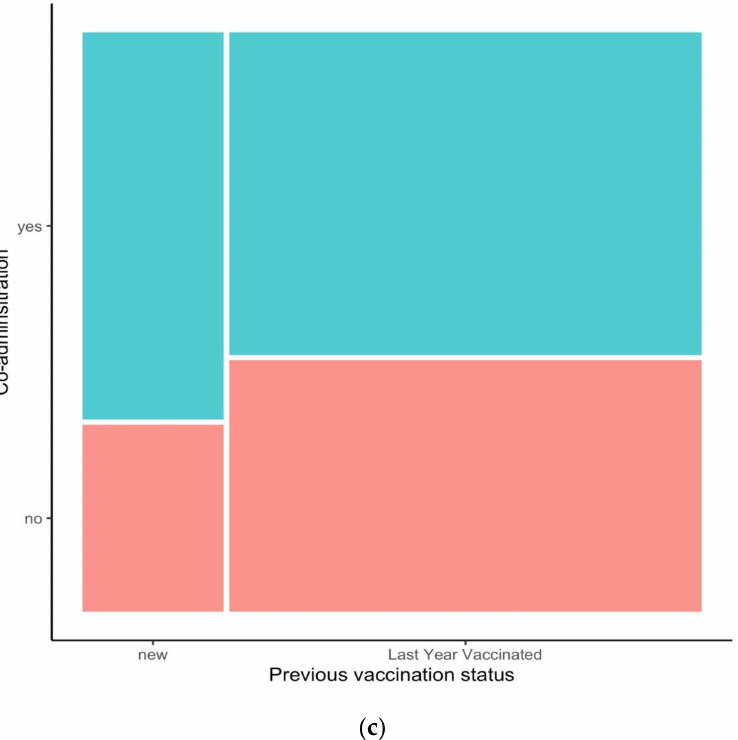
Figure 2. Mosaic plots exploring HCWs’ qualification ( a ), area of activity ( b ), and flu/COVID-19 vaccines coadministration ( c ) in newly vaccinated HCWs (“New”) versus HCWs who got vaccinated also in the 2020–2021 season (“Last Year